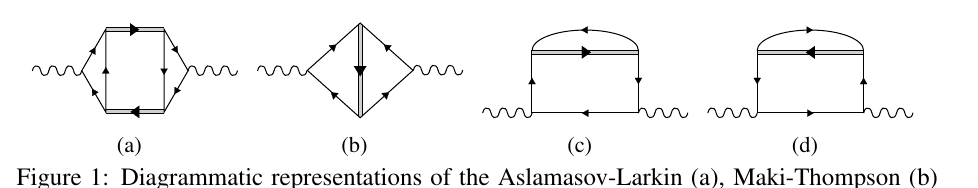
Figure 1: Diagrammatic representations of the Aslamasov-Larkin (a), Maki-Thompson (b) and density of states (c,d) terms with the diquark soft mode. The wavy and double lines are photons and the diquark soft modes,